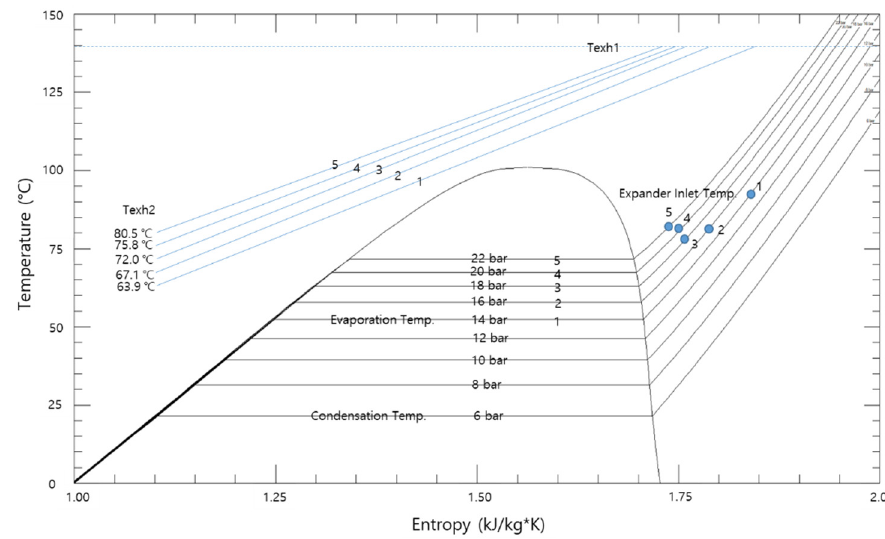
Figure 10. Increase in the evaporation pressure in temperature–entropy diagram.